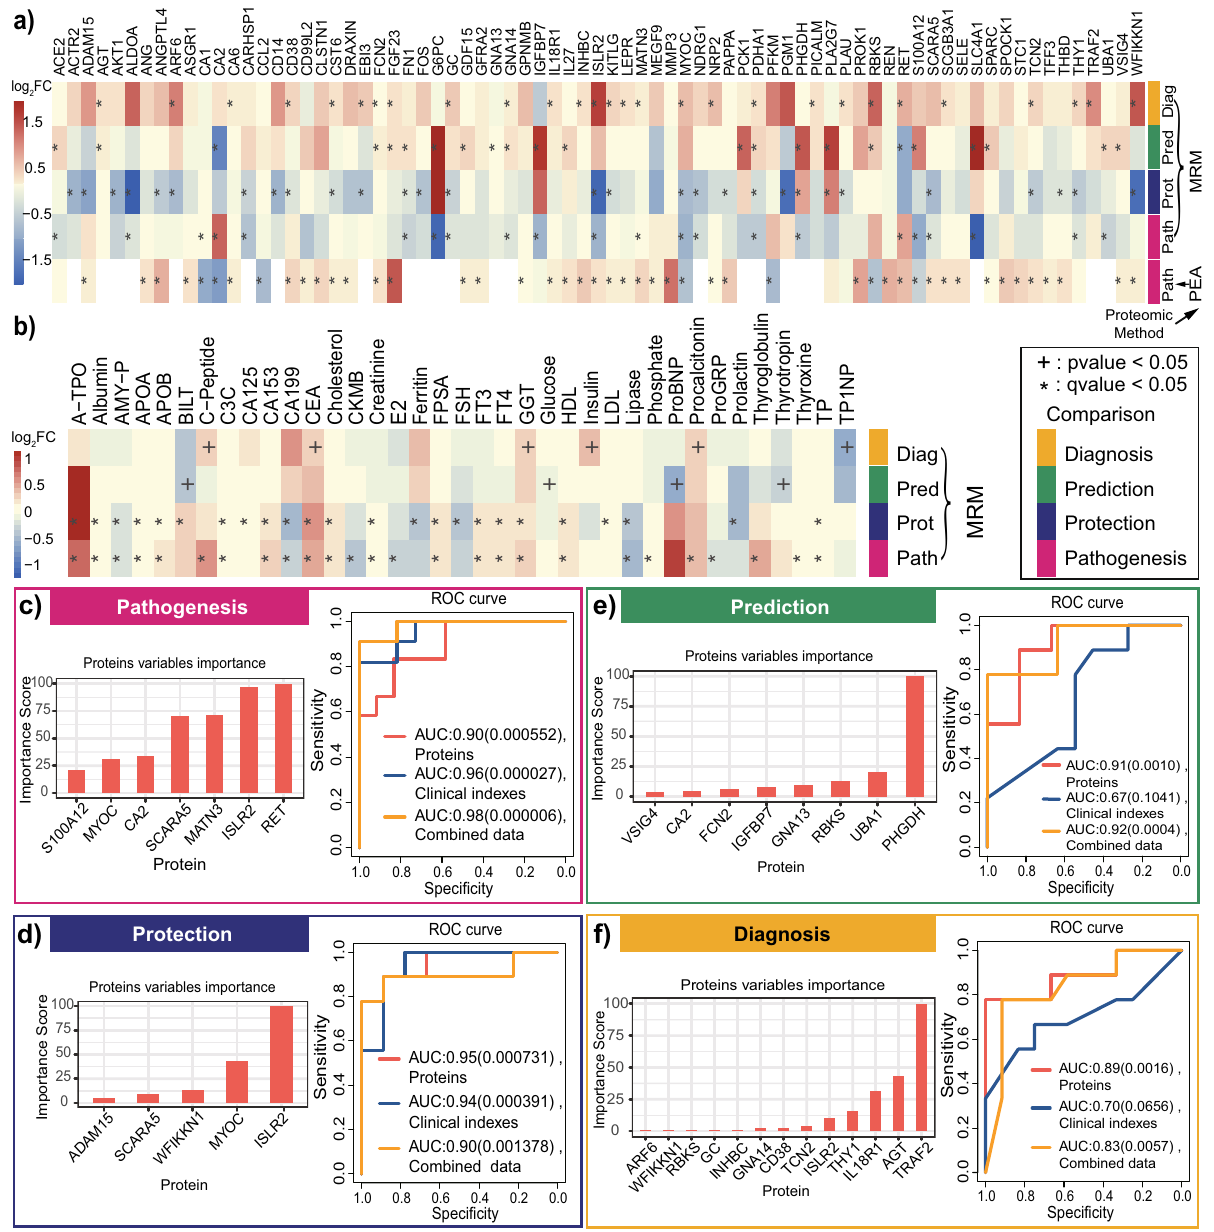
Fig. 3 Differential analysis and classi fi cation with MRM-identi fi ed DEPs and clinical indexes. Differential analysis and machine learning were performed with the identi fi ed proteins and clinical indexes in four comparison groups (pathogenesis: AMS4k ( n = 30) and AMS1k ( n = 30); protection: nAMS4k ( n = 23) and nAMS1k ( n = 23); prediction: AMS1k ( n = 30) and nAMS1k ( n = 23); and diagnosis: AMS4k ( n = 30) and nAMS4k ( n = 23). a Heatmap of the log 2 FC of 75 PEA- or MRM-identi fi ed DEPs in the 5 comparison groups based on PEA or MRM. b Heatmap of the log 2 FC of 37 differential clinical indexes involved in the 4 comparison groups. The heatmap depicts the regulation trends of each protein or clinical index with the legend at the left of the fi gure. The statistical methods were used paired/unpaired t test or Welch ’ s t test. The differentially expressed proteins and clinical indexes are labeled with * ( q value < 0.05) and + ( p value < 0.05). c ROCs of the classi fi cation models with proteins (orange curve), clinical indexes (blue curve), or combined data (yellow curve) and bar plot of important proteins (orange bar) between AMS4k and AMS1k (pathogenesis, pink box). All the pathogenesis models with three types of features exhibited high accuracy with statistical signi fi cance, as demonstrated by the AUCs and p values. d ROCs of the classi fi cation models with proteins (orange curve), clinical indexes (blue curve), or combined data (yellow curve) and bar plot of important proteins (orange bar) between the nAMS4k and nAMS1k groups (protection, dark blue box). All protection models with three types of features show high accuracy with statistical signi fi cance. e ROCs of the classi fi cation models with proteins (orange curve), clinical indexes (blue curve), or combined data (yellow curve) and bar plot of important proteins (orange bar) between the AMS1k and nAMS1k groups (prediction, dark green box). The prediction models with proteins and combined data show high accuracy. f ROCs of the classi fi cation models with proteins (orange curve), clinical indexes (blue curve), or combined data (yellow curve) and bar plot of important proteins (orange bar) between the AMS4k and nAMS4k groups (diagnosis, yellow box). The diagnosis models with proteins and combined data exhibit high accuracy with statistical signi fi cance. The p value (in parentheses) of each AUC is shown after the AUC value. ROC receiver operating characteristic curve, AUC area under the